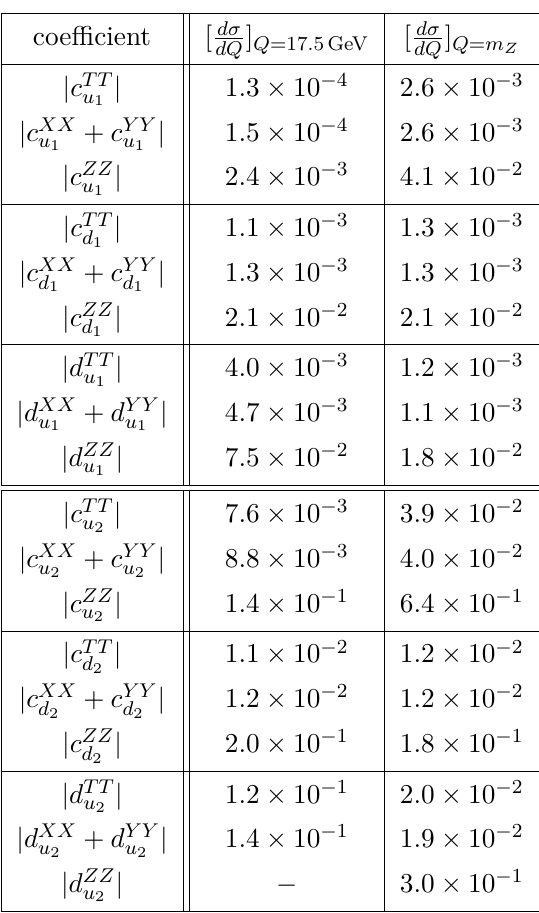
has no sensitivity at u 2